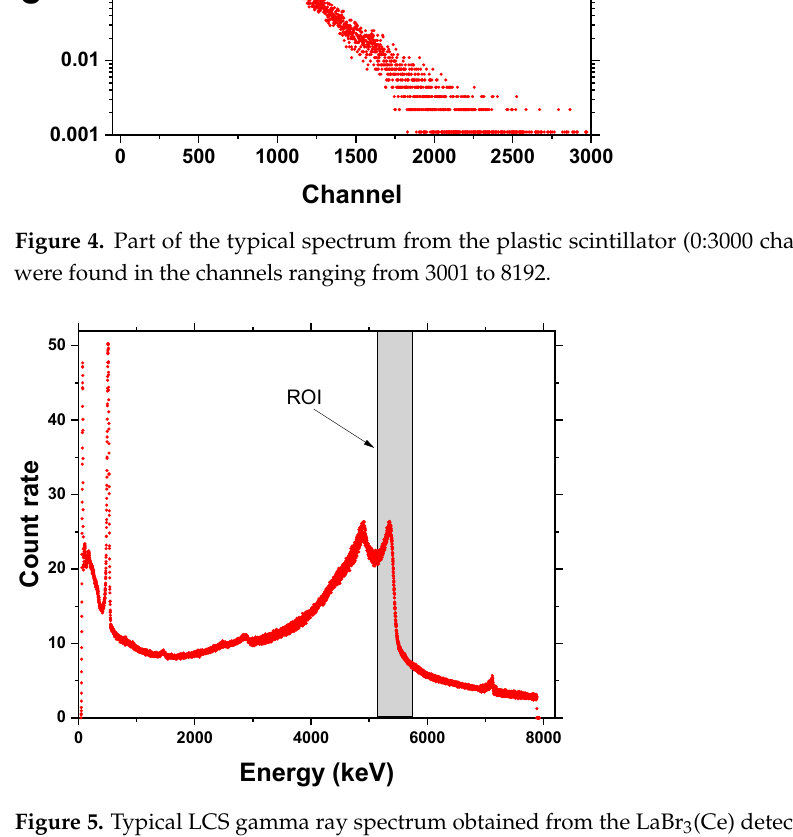
Figure 4. Part of the typical spectrum from the plastic scintillator (0:3000 channel). A few events were found in the channels ranging from 3001 to 8192.